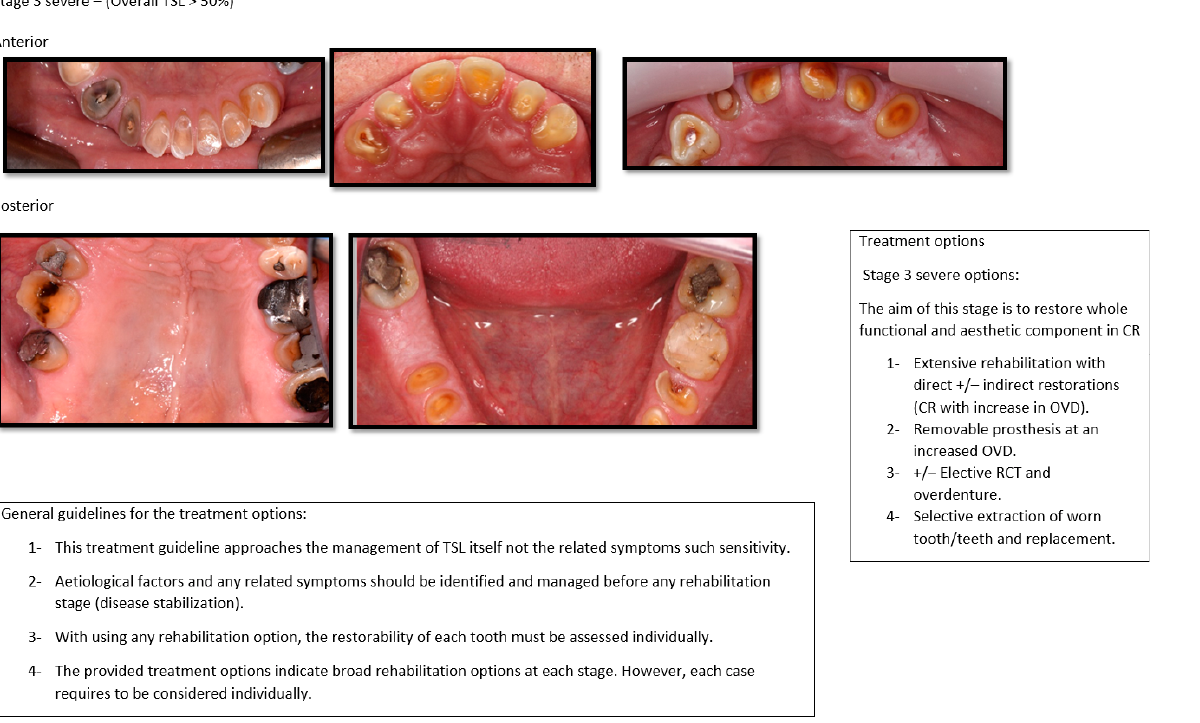
Figure 5. Photographic version of the classification tools with suggested treatment for Stage 3.